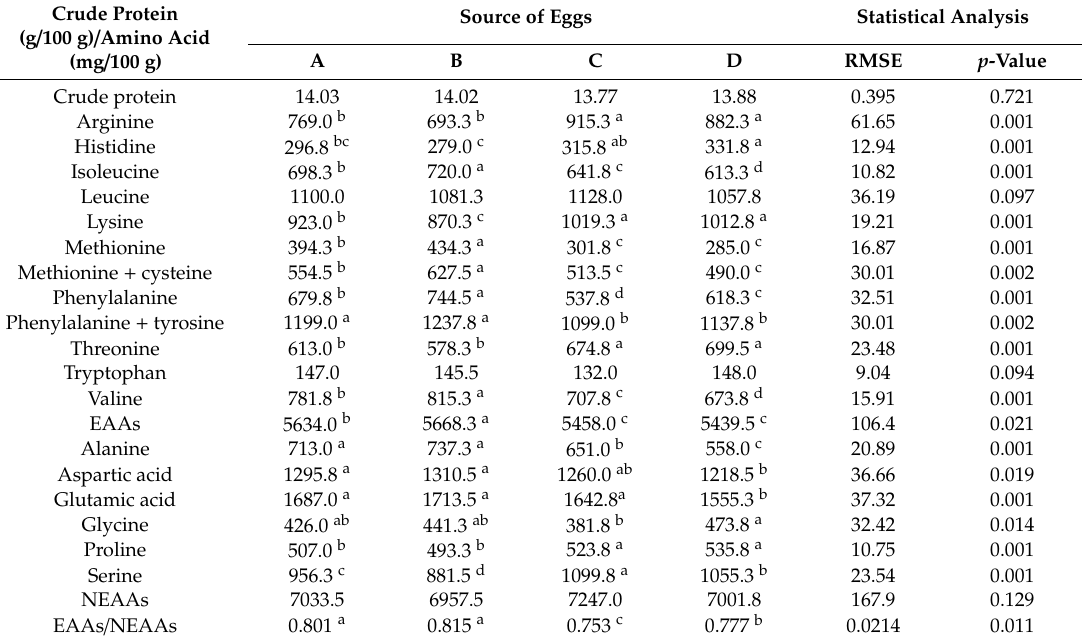
Table 1. Crude protein and amino acid patterns of whole edible parts of eggs of di ff erent sources in the retail